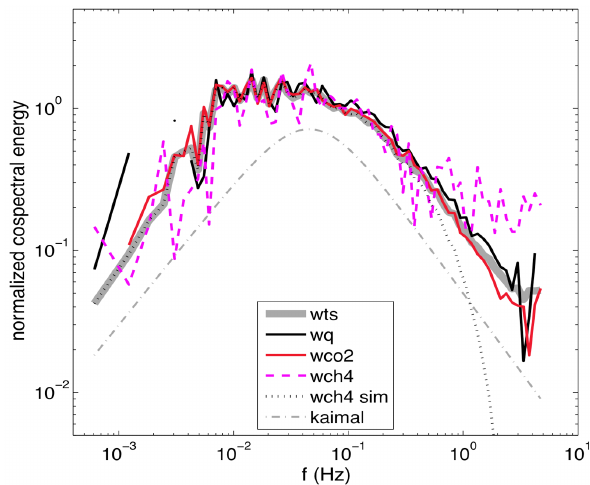
Fig. B2. Normalized averaged co-spectra from an ensemble of 109 half hour nighttime runs obtained between 20:00h and 05:00h from February to July 2009. The co-spectra for sonic temperature, wa- ter vapor, CO 2 and CH 4 flux are plotted as a function of natural frequency. The dotted black curve (CH 4 simulated) represents an estimate of the expected shape of the co-spectrum of CH 4 without the influence of signal noise. The dashed grey curve is the arbitrar- ily offset near-neutral universal co-spectrum (Kaimal et al., 1972; Kaimal, 1973). The average stability and wind speed for the en- semble are z/L =+ 0 . 65 and u = 2 . 2 ± 0.6m s − 1